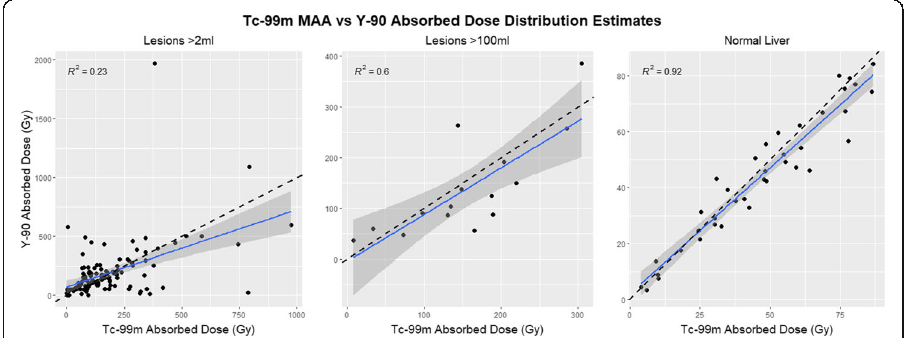
Fig. 3 Comparison between absorbed dose estimates for 99m Tc-MAA SPECT and 90 Y PET. The dashed line denotes the identity line while the solid line shows the current linear